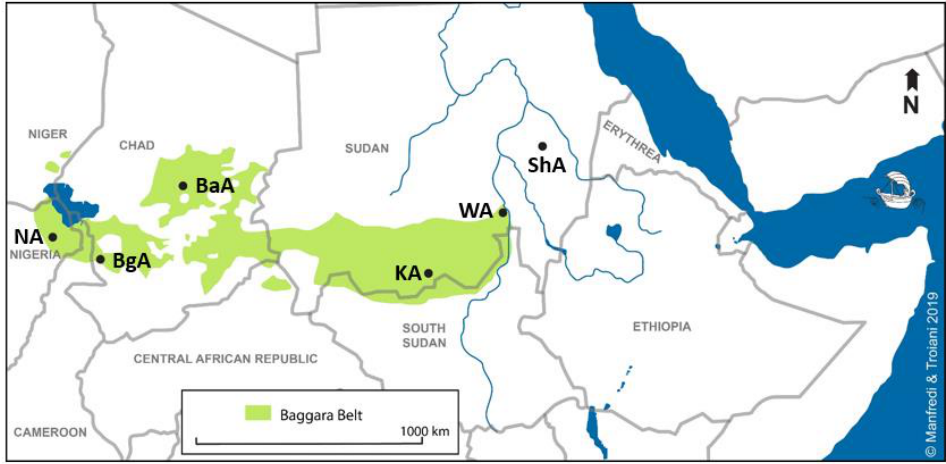
Figure 2. The geographical distribution of the Arabic dialects of the